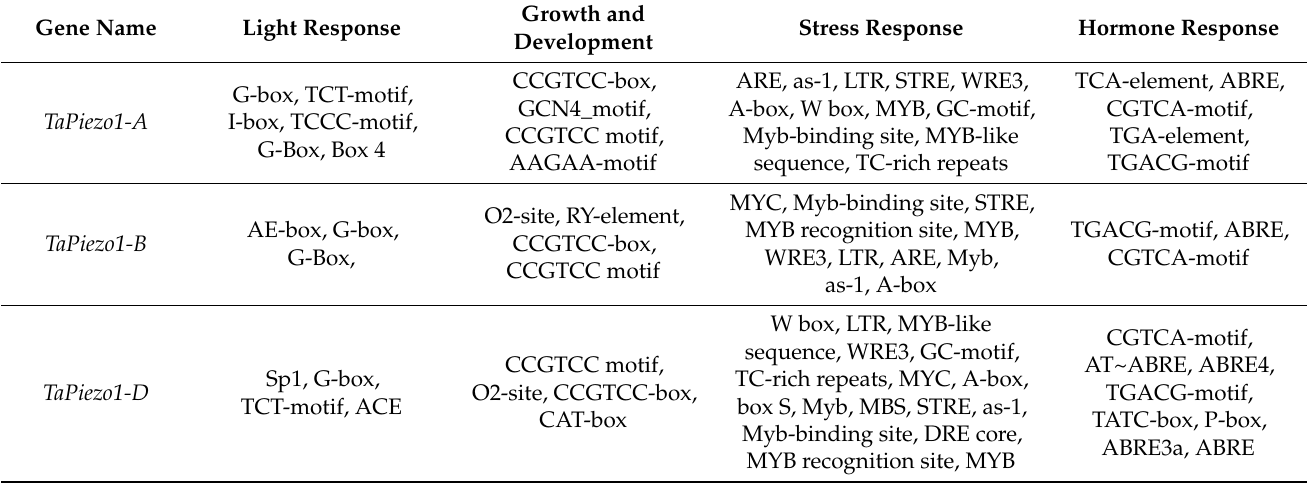
Table 2. Various types of Cis -regulatory elements of TaPiezo